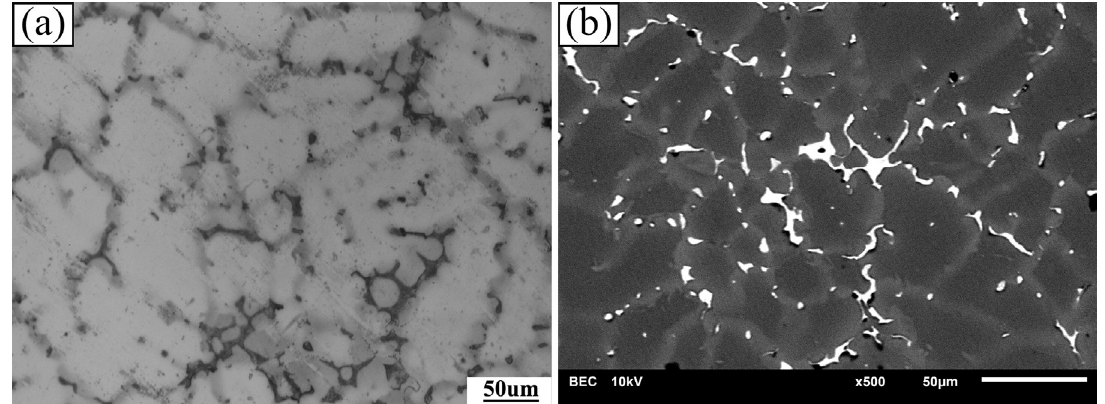
Figure 1. OM image (a) and back-scattered SEM image (b) of as-cast alloys.